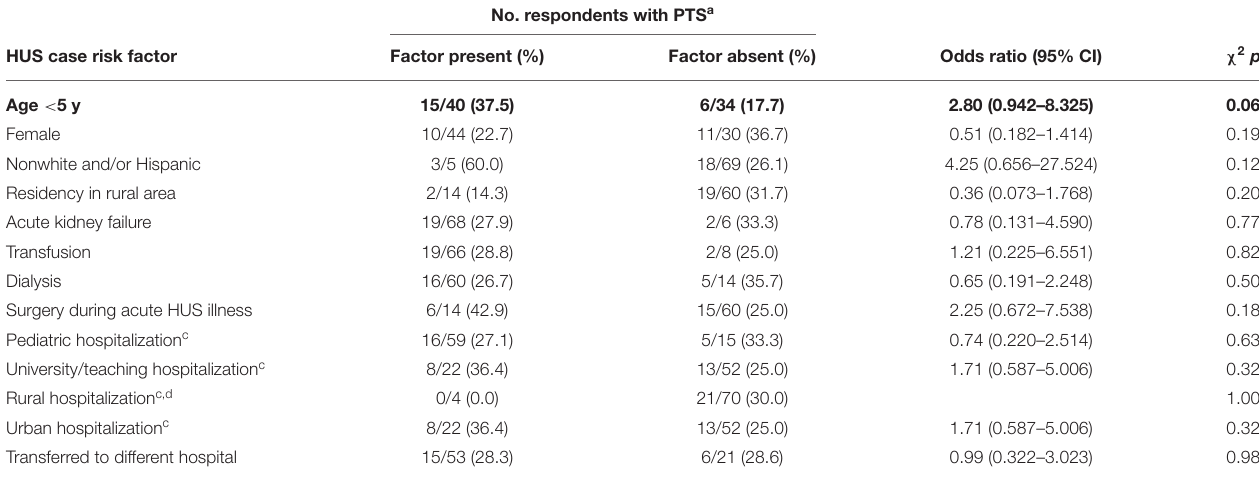
TABLE 8 | Univariable logistic regression associations between acute risk factors and posttraumatic stress among respondents following an HUS event. No. respondents with PTS